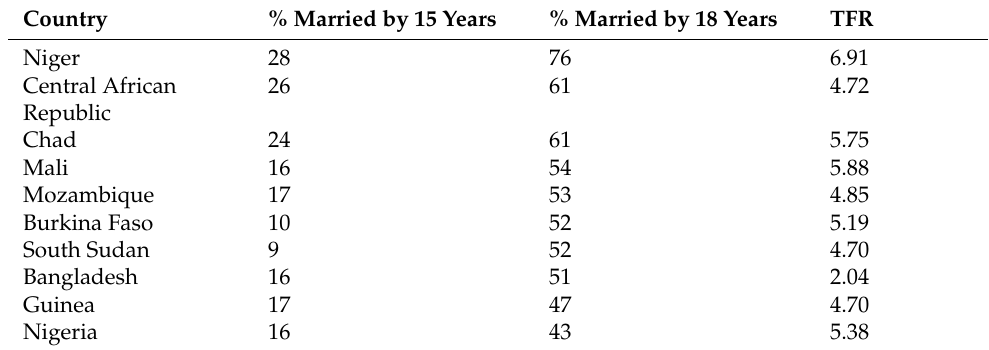
Table 1. Prevalence of female marriage under the ages of 15 and 18 years in the 10 countries with the highest rates of marriage among minors and total fertility rate (TFR). Data source: (UNICEF 2020). Country % Married by 15 Years % Married by 18 Years